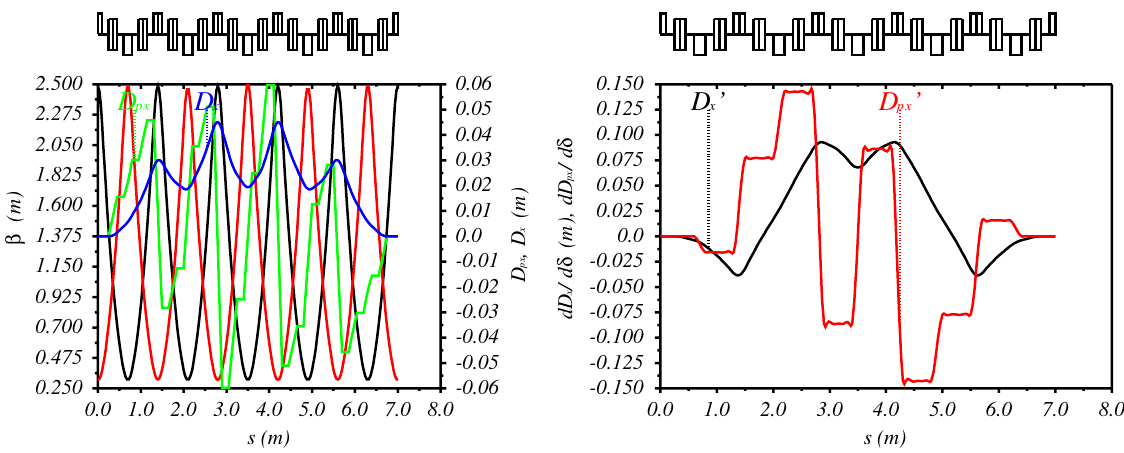
FIG. 11. Left: Relative change in projected normalized emittance versus the mismatched beta function, for two different emittances, ¼ (cid:7)(cid:8) ¼ 0 : 5 (cid:9) m and (cid:7)(cid:8) ¼ (cid:7)(cid:8) ¼ 5 (cid:9) m . Right: Relative change in projected normalized emittance versus initial alpha (cid:7)(cid:8) x y x y function when generating the